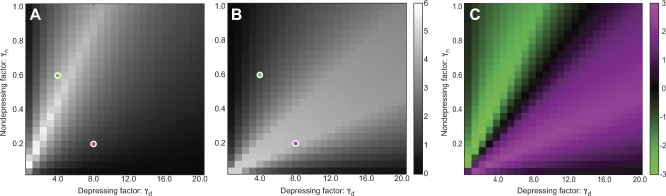
Magnitude of Direction Selectivity to a Moving Pulse Stimulus as a Function of Synaptic Factors(A) Initialized with 50% grey. (B) Initialized with Global Synchronous Gamma-Band Oscillations. Direction selectivity is quantified, in each condition, as the ratio (in decibels) of the peak values of V
∞(t) – V
0 in response to the pulse in the preferred to the non-preferred directions (solid and dotted curves in Figure 3). Brighter shades of grey indicate more direction selectivity. Colored circles indicate parameter values used in Figure 3.(C) Magnitude of enhancement (magenta) or reduction (green) of the directional response caused by the addition of global synchronous gamma-band oscillations. This measurement was quantified by the difference between the values calculated for (A) and (B). The color indicates sign of difference; intensity indicates magnitude.